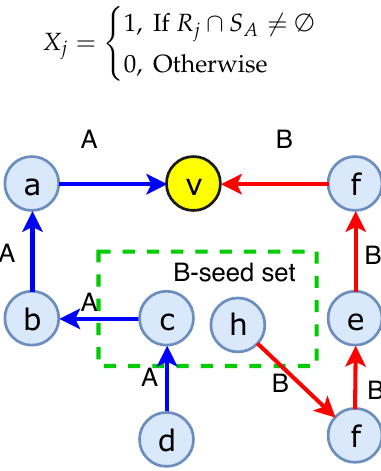
Figure 4. Description for C U ( g , v )